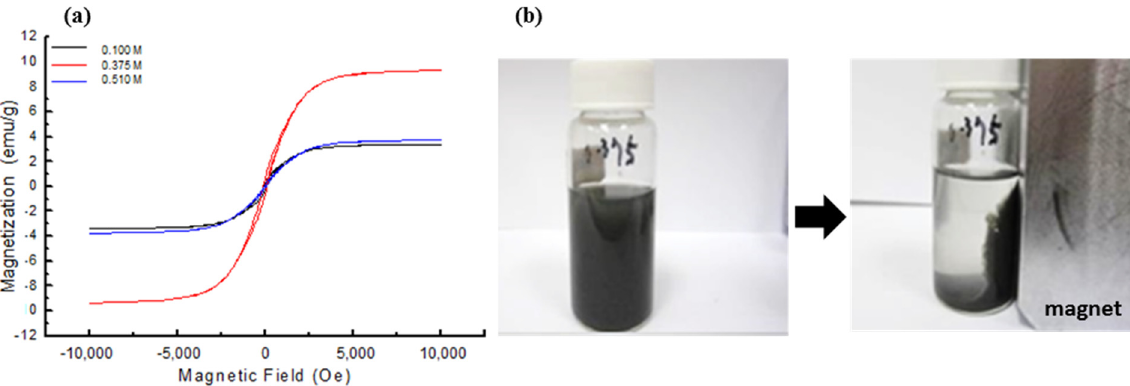
Figure 3. ( a ) The M ‐ H hysteresis loops of SiO 2 @Fe/SiO 2 spheres prepared with Fe precursor (FeCl 3 ∙ 6H 2 O) at 0.1 M, 0.375 M and 0.51 M; ( b ) photographs of the SiO 2 @Fe/SiO 2 composite (0.375 M)